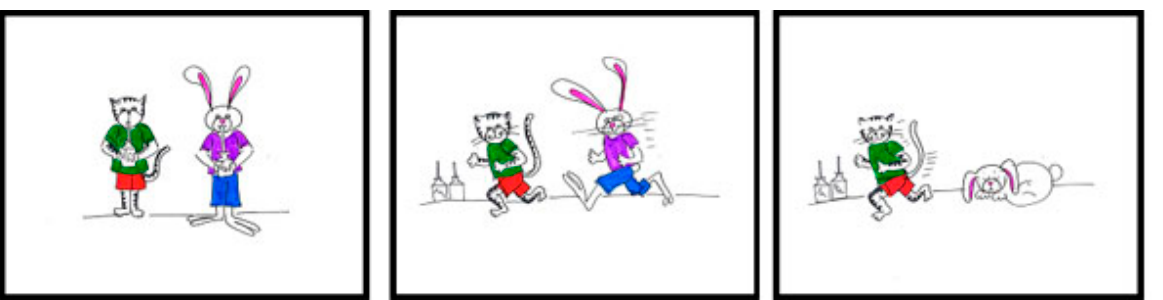
Figure A5. Practice stimulus 5. Appendix A.2. Subject Relative Clause Stimuli El oso, que besa al mono, abraza al perro. Figure A6. SRC stimulus 1. El perro, que golpea al gato, besa al mono.